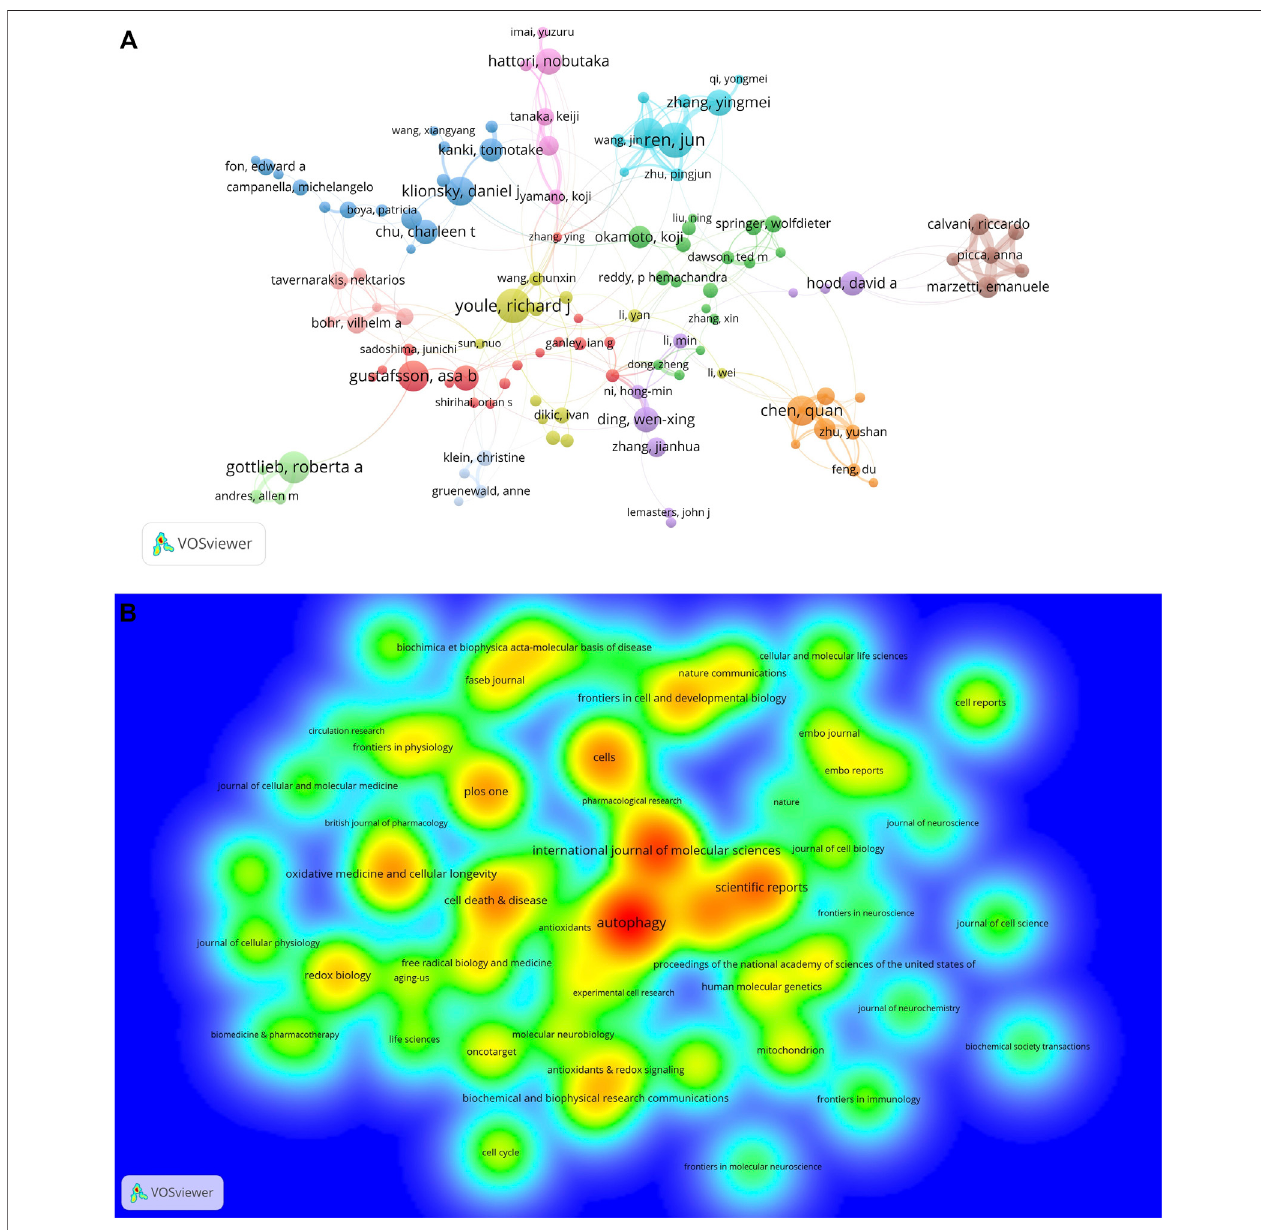
FIGURE5| Co-authorshipofauthorsandproductivejournalsonmitophagy. (A) Co-authorshipnetworkofauthorsinthe fi eldofmitophagy. (B) Densitymapoftop 56 most productive journals published papers on mitophagy.